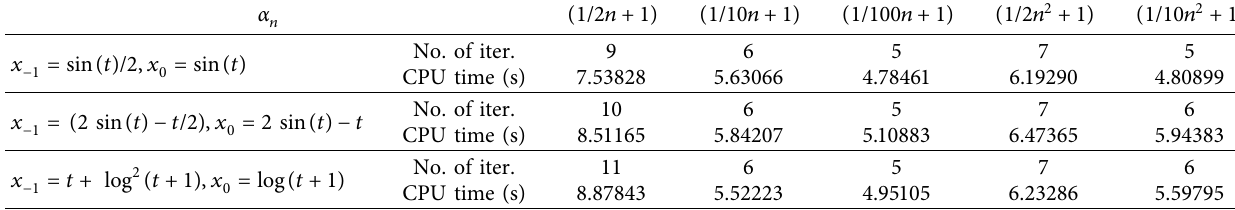
Table 4: Numerical results of the difference β